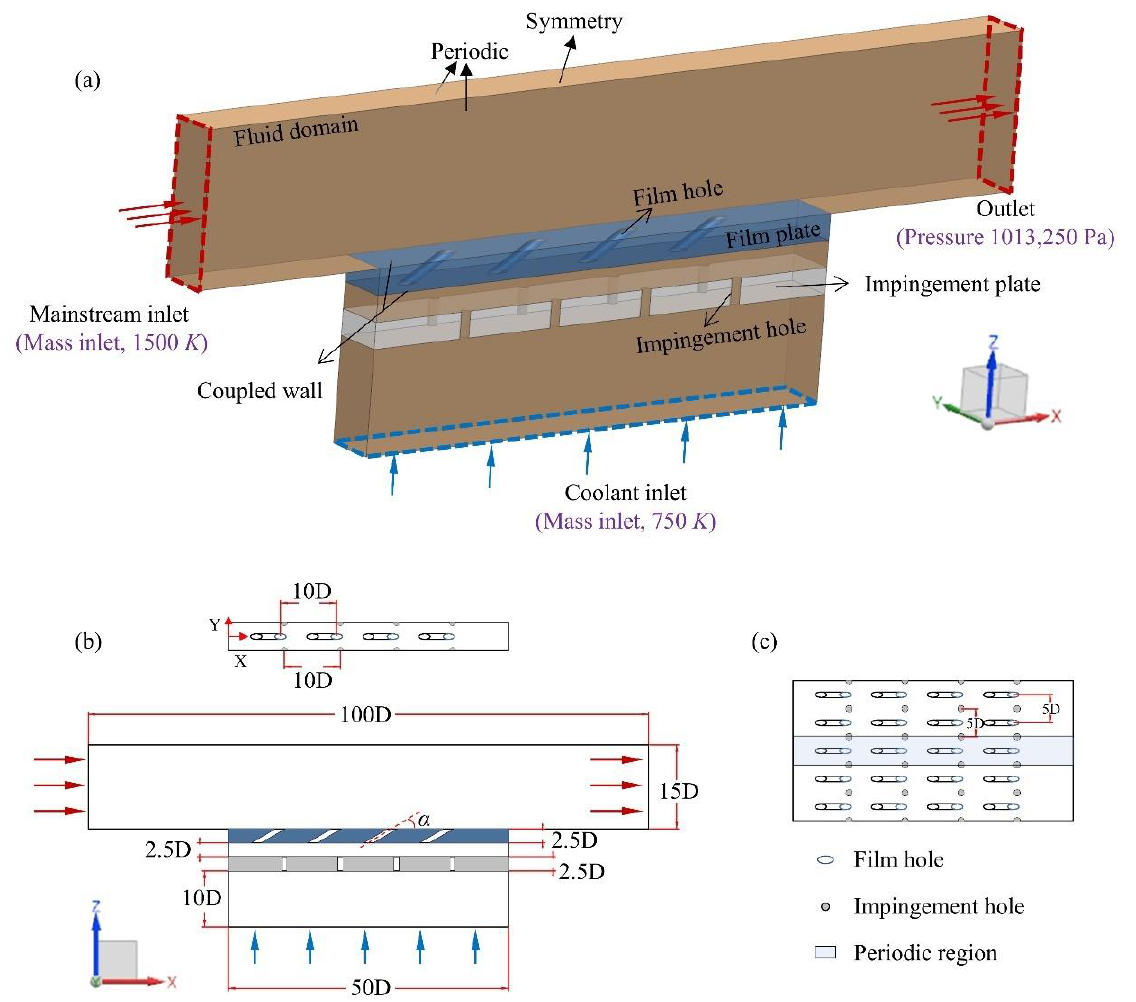
Figure 1. ( a ) Computational model of impingement/effusion cooling system and boundary condi- tions for conjugate heat transfer analysis; ( b ) information on the model’s dimensions; ( c ) arrangement of impingement and film holes.